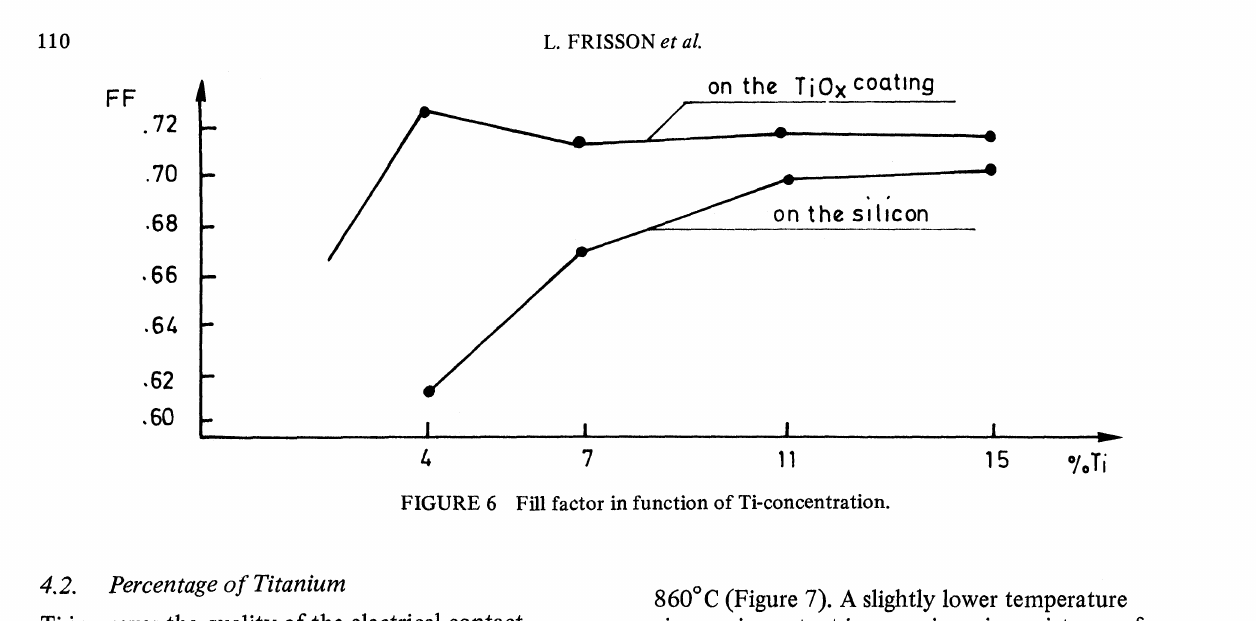
FIGURE 6 Fill factor in function of Ti-concentration.